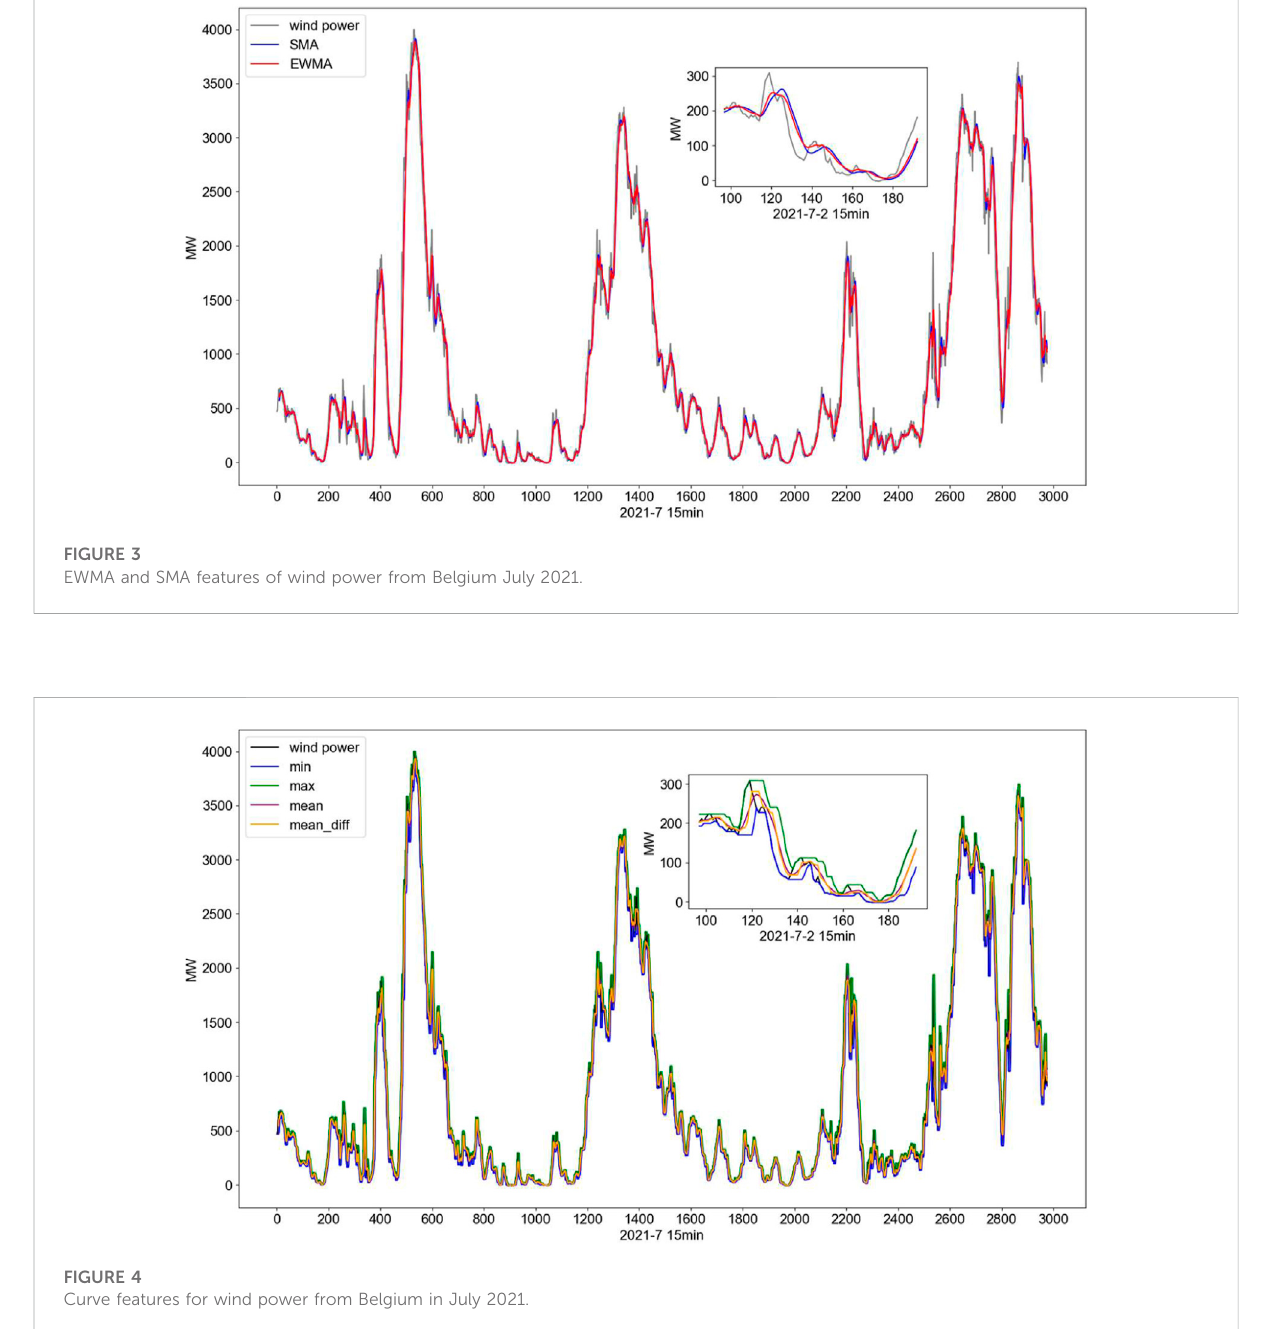
Figure 4 shows the curve characteristics of wind power.